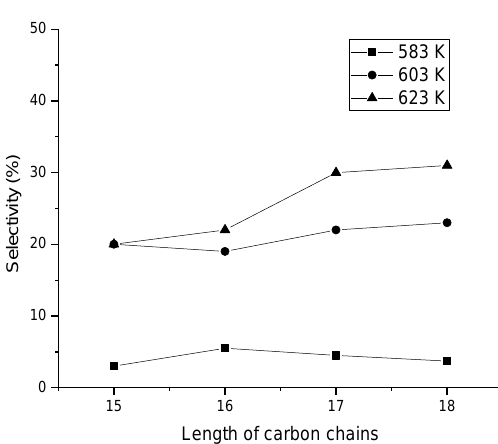
Figure 4. Effect of carbon chain length in the hydroisomerization using Ni-Mo-SAPO 11 as a catalyst under 30 bar with H 2 /oil (C15–C18 alkanes) ratio of 800 with liquid hourly space velocity (LHSV) of 1 hr −1 [20]. Reproduced with permission from Xing et al., Catal. Today ; published by Elsevier, 2018 . Hydroisomerization of a mixture of C15–C18 hydrocarbons over Ni-Mo-SAPO-11 was